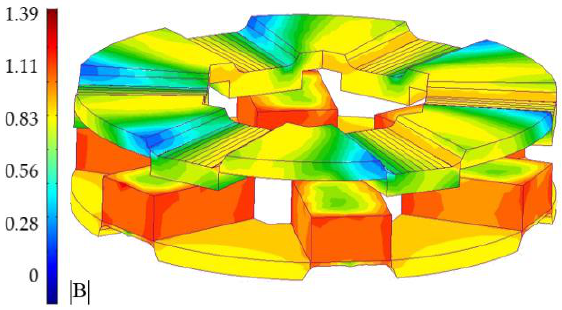
Figure 6. GA optimal design with the distribution of magnetic flux density. Table 2. Simulation results of genetic algorithm (GA) optimization.